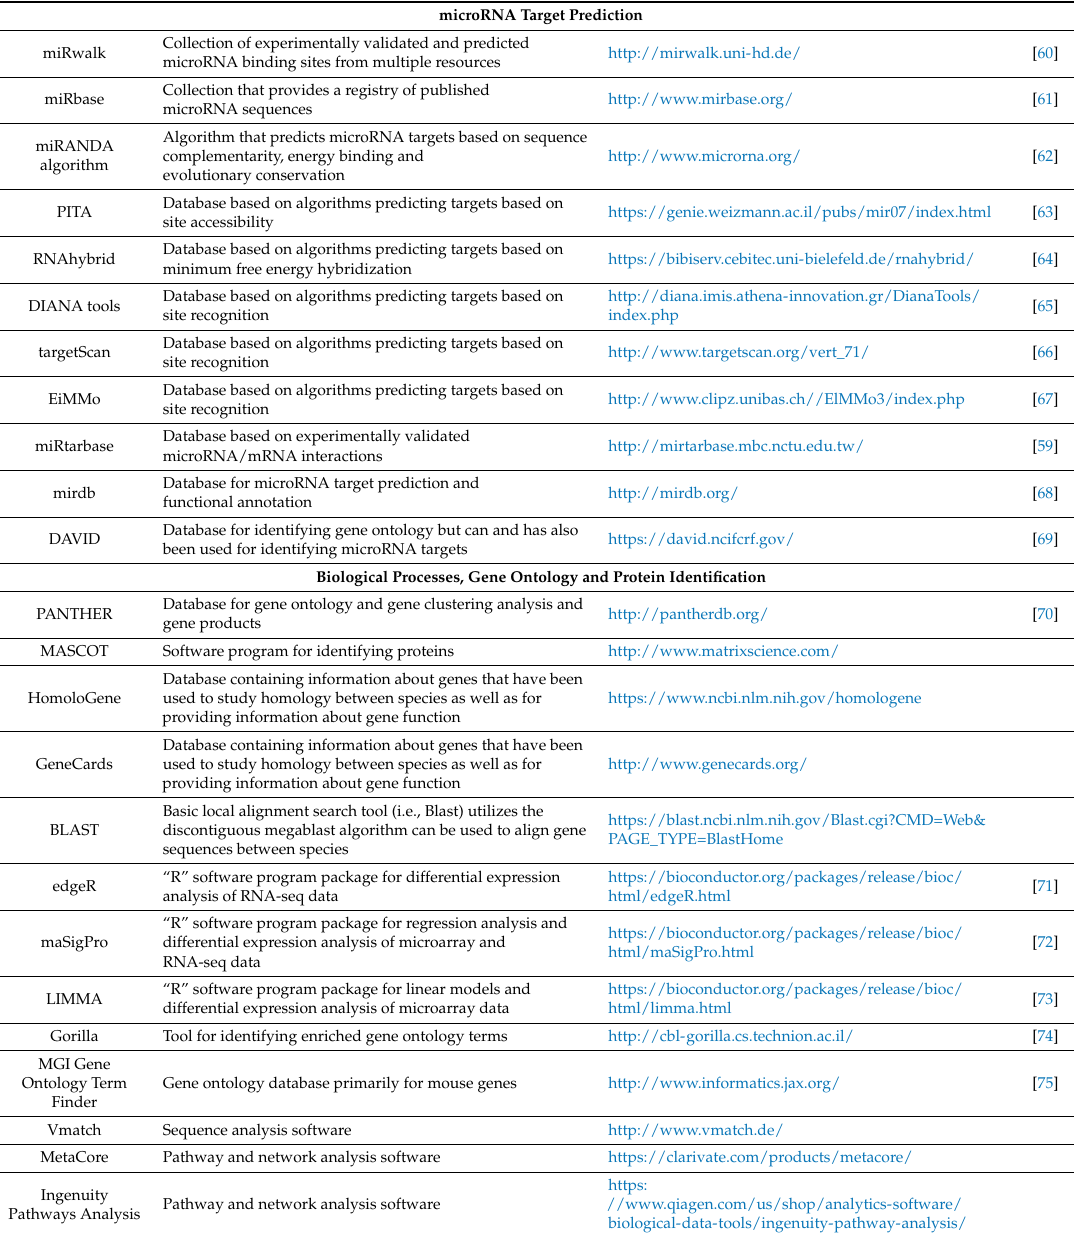
Table 2. Summary of bioinformatics